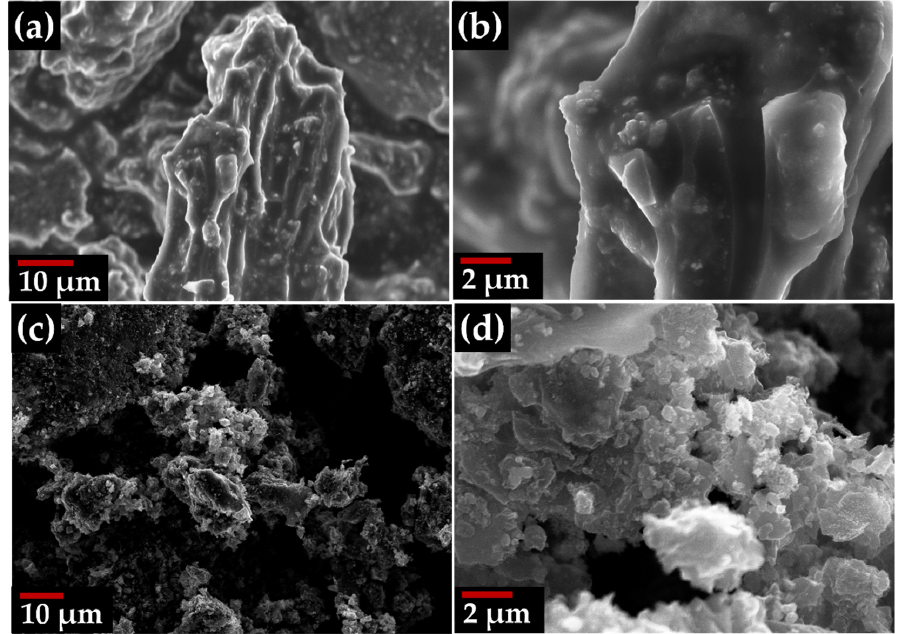
Figure 4. FESEM images of C-surgical ( a , b ) at different magnification) and C-FFP2 ( c , d ) at different